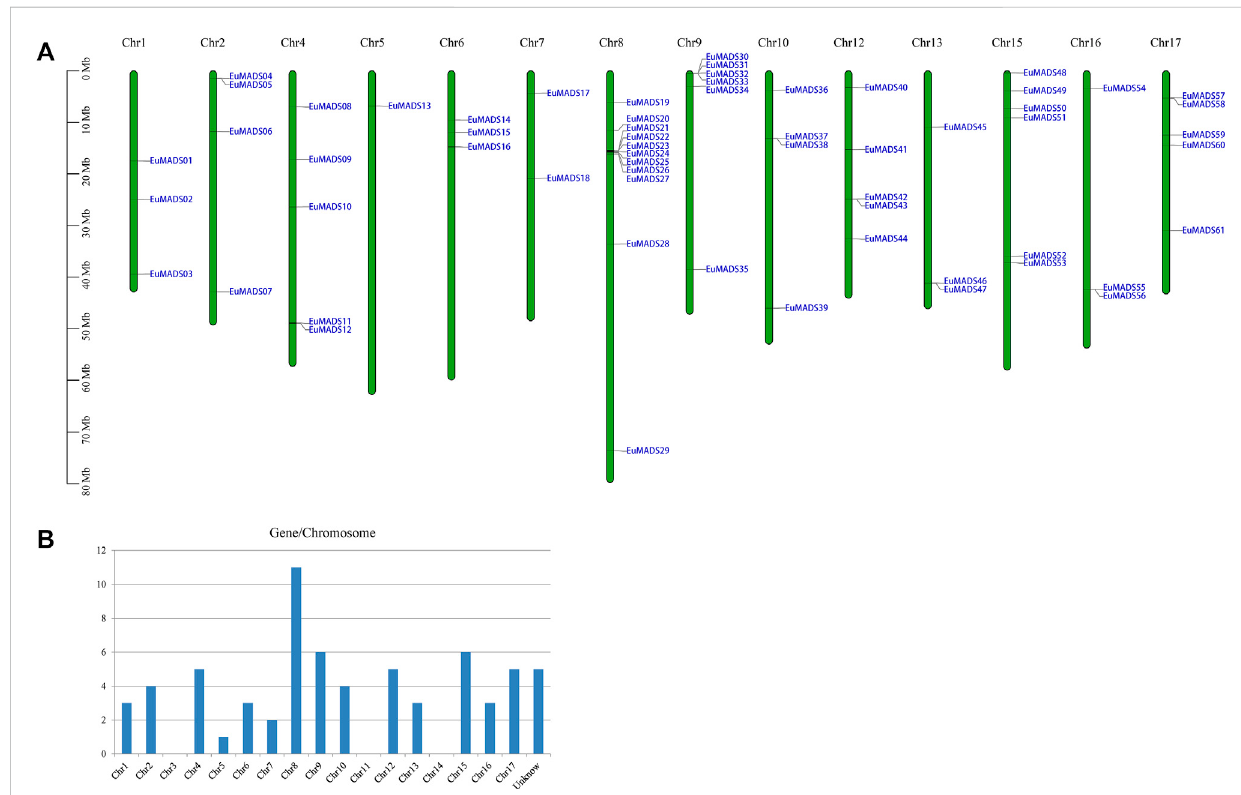
FIGURE 1 Chromosomaldistribution ofthe66 EuMADS genes. (A) Schematic representation ofthechromosomal localization of EuMADS genes.Each vertical bar represents one chromosome indicated by numbers above. Chromosome length is scaled on the left. (B) The density of EuMADS genes on each chromosome. EuMADS genes with unknown chromosomal position are shown as